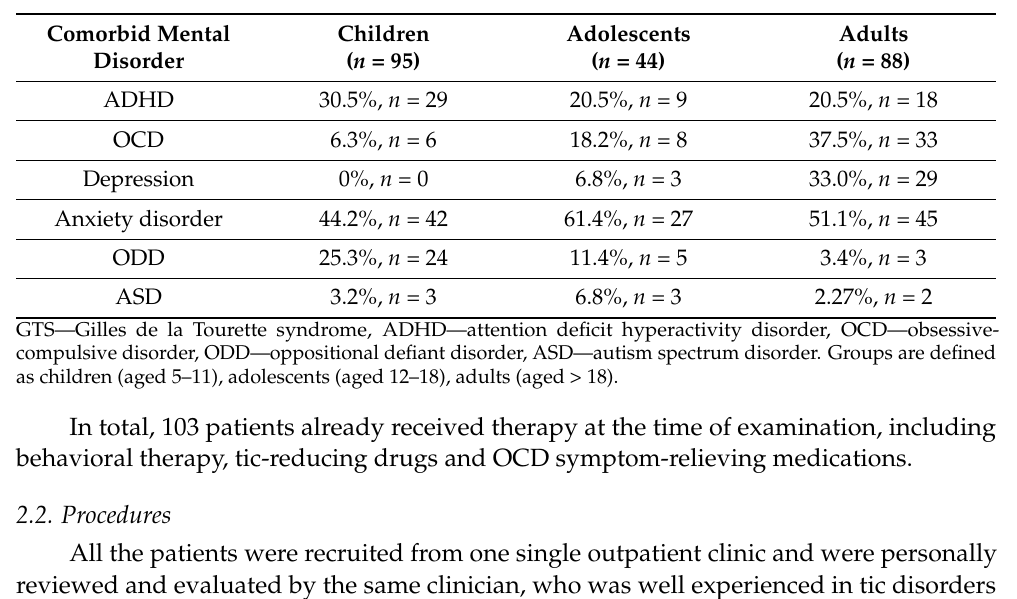
Table 1. Psychiatric comorbidities in children, adolescents and adults with